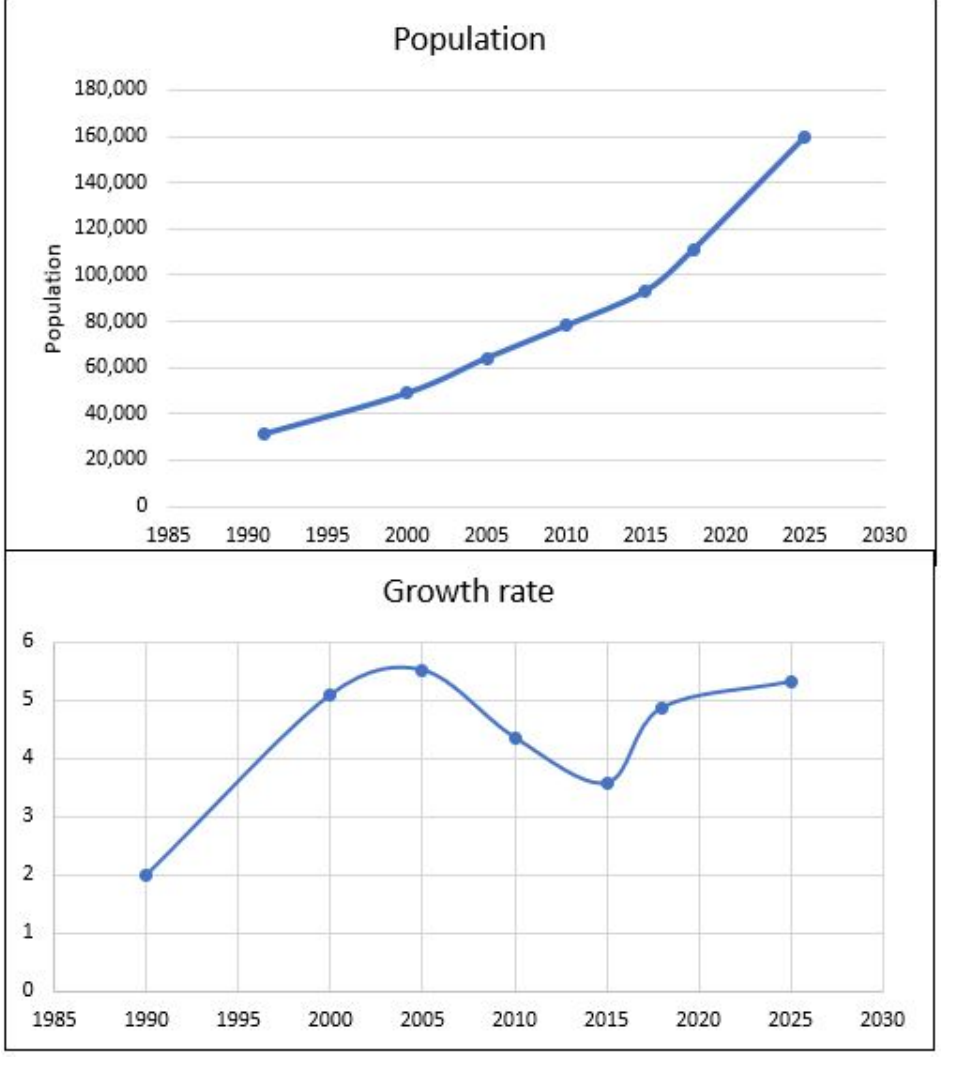
Figure 2. Population distribution of Adenta municipality from 1991 to 2025.